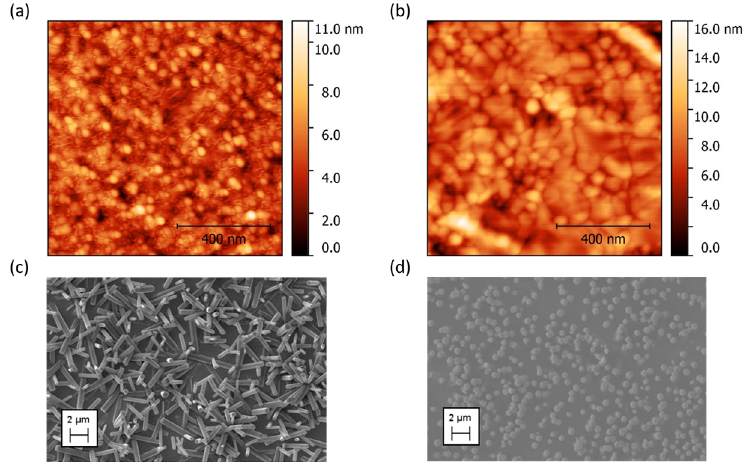
Figure 7. AFM images of Au deposited on polyimide substrates ( a ) before and ( b ) after annealing at 100 °C for 15 minutes. SEM images of ZnO NRs grown on substrates, ( c ) untreated and ( d ) annealed at 100 °C for 15 minutes.